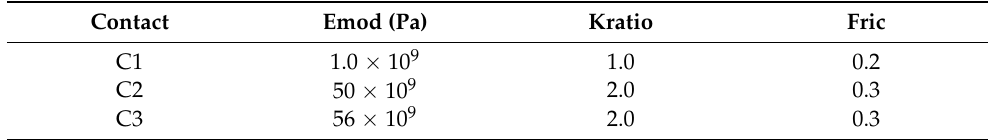
Table 6. Micro ‐ parameters of different interfaces. Table 6. Micro-parameters of different